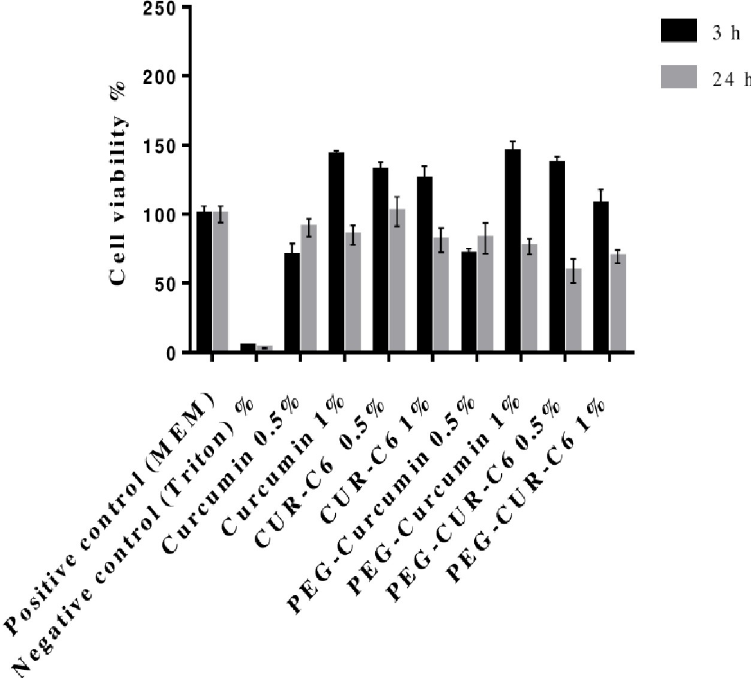
Fig 7. Represents Caco-2 cell viability after 3h (black bar) and 24 h (grey bar) of incubation at 37˚C of pure Curcumin, CUR-C6, PEG-Curcumin, PEG-CUR-C6 (0.5% and 1% w/v each) as compared to 2% triton X-100 (negative control) and MEM (positive control). Data is shown as mean ± SD (n = 3).